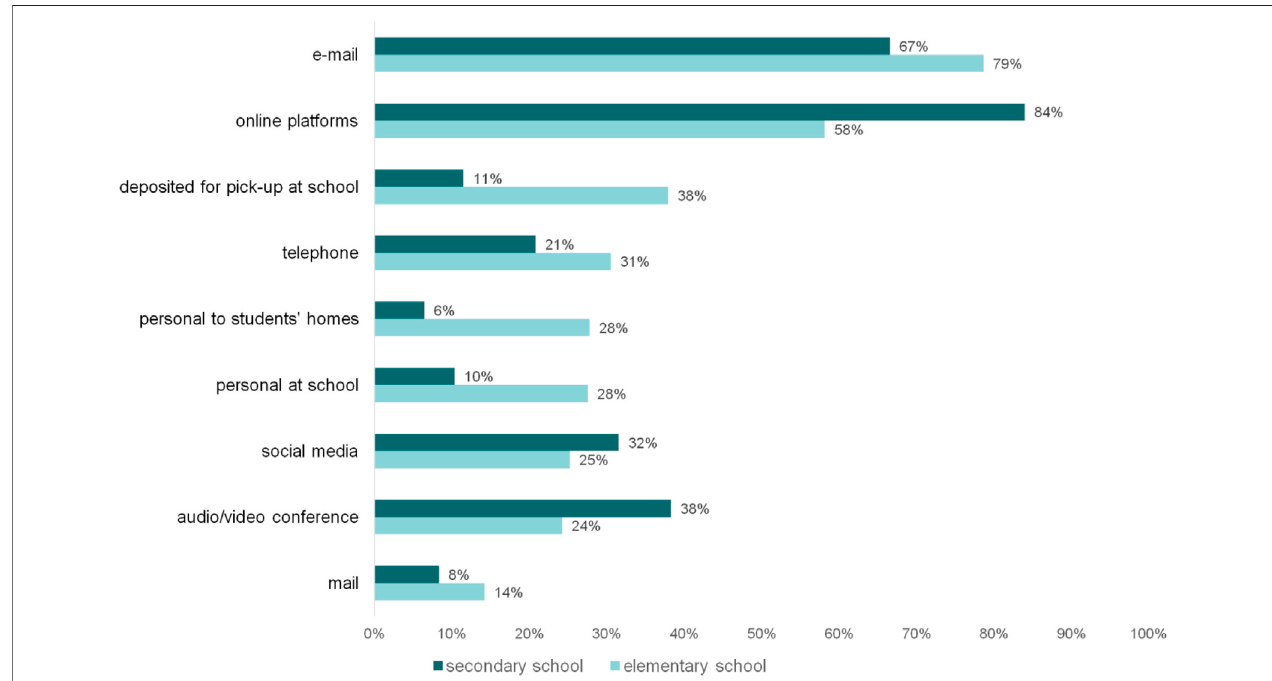
FIGURE 4 | Percentage of teachers using the indicated communication channels to distribute work assignments and learning material at least once a week.